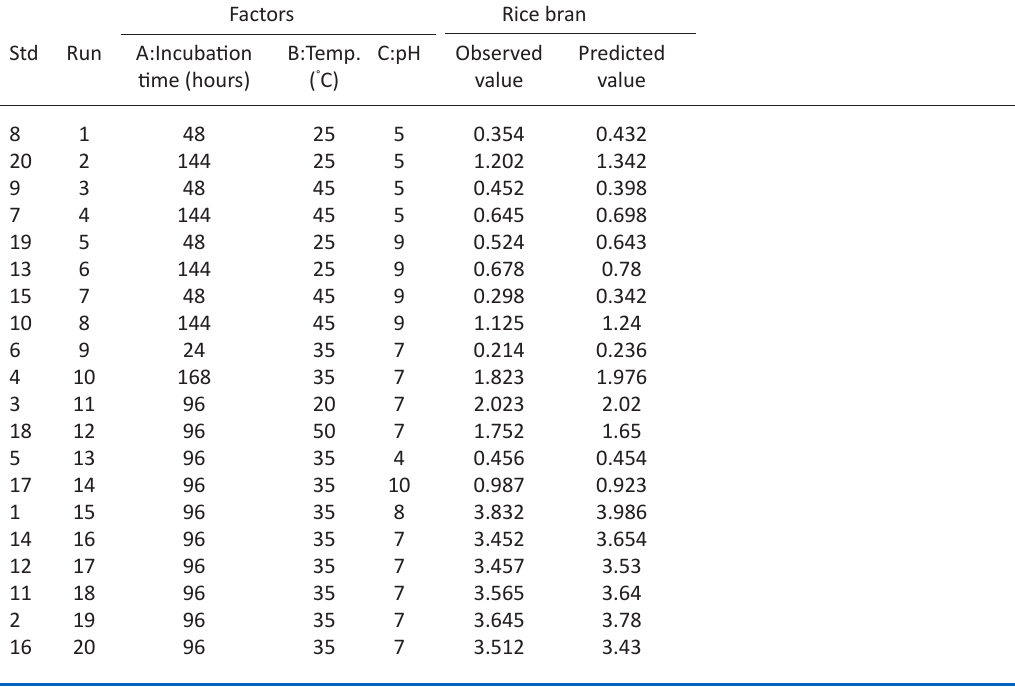
Table 1. Central composite experiments design matrix with observed and predicted values of laccase production in rice bran by Bacillus sp.